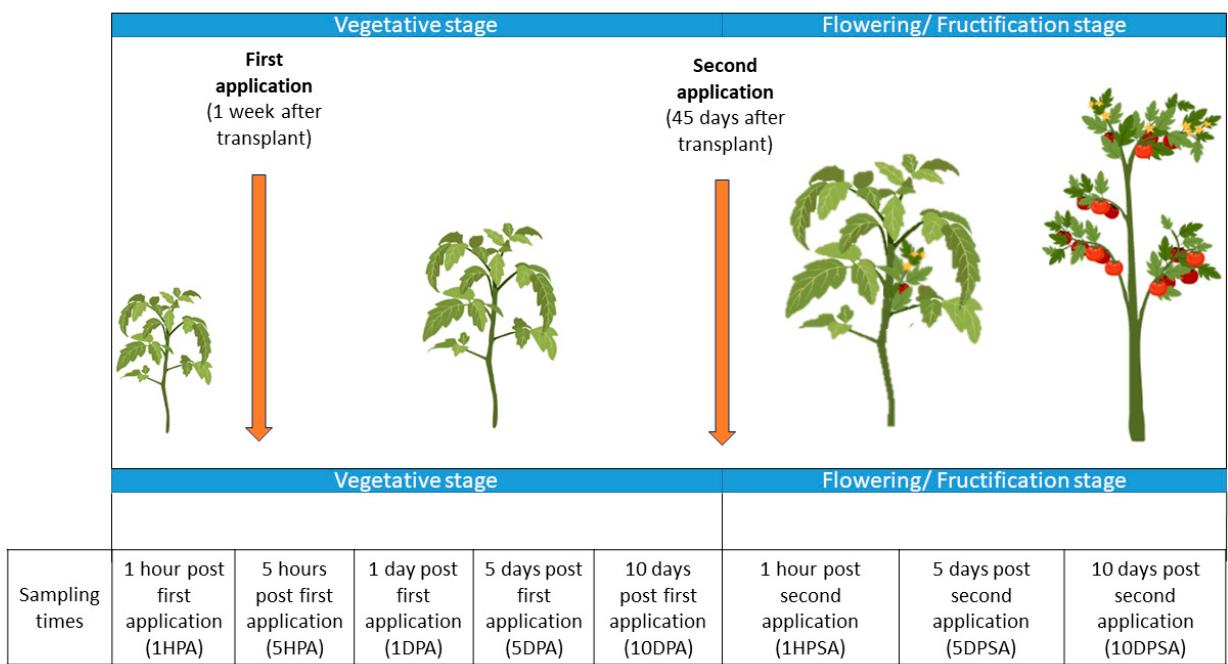
Figure 1. Timeline graphical representation of the experiment carried out in this work. The times of eDNA application are abbreviated from now as follows: 1 h after first application (1 HPA), 1 day after first application (1 DPA), 1 h after second application (1 HPSA) and 5 days after second application (5 DPSA). Some elements were created with BioRender.com